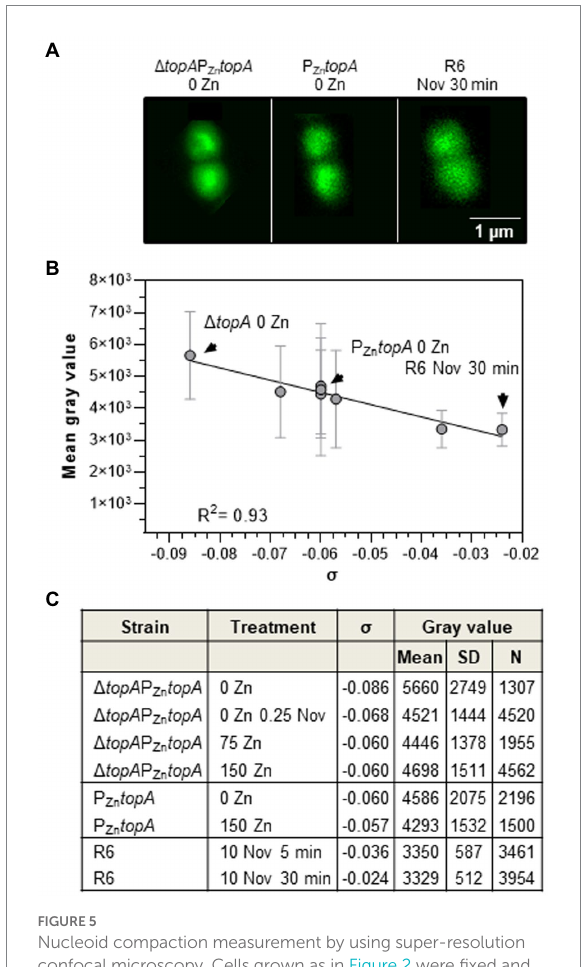
FIGURE 5 Nucleoid compaction measurement by using super-resolution confocal microscopy. Cells grown as in Figure 2 were fixed and stained with Sytox orange as described in the section “Materials and methods.” Additionally, a culture of strain R6 was grown until OD 620nm = 0.4 and treated with 10 × MIC of Nov for 5 or 30 min. (A) Stimulated emission depletion (STED) microscopy images of cells indicated. (B) Correlation between values obtained in confocal microscopy vs. σ values estimated in 2D-agarose gels of strains and treatments indicated in (C) . Mean values ±SD are represented. Points corresponding to images in (A) are indicated with an arrow. (C) Table showing data represented in (B) , indicating mean gray value, SD, and number of cells studied (N).